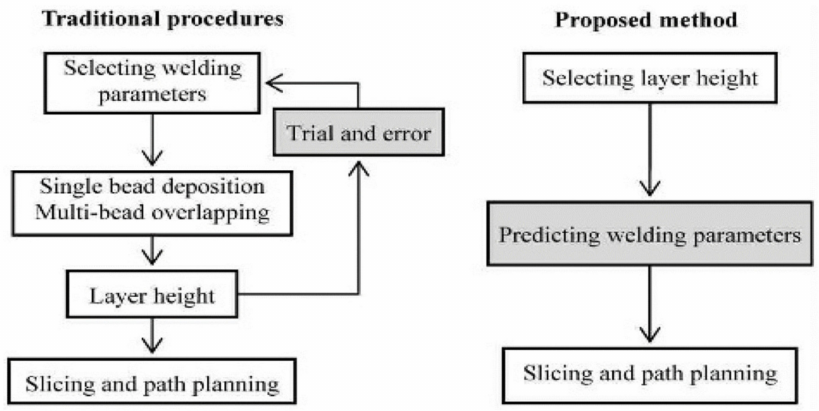
Figure 13. Parameter determination in welding arc additive manufacturing